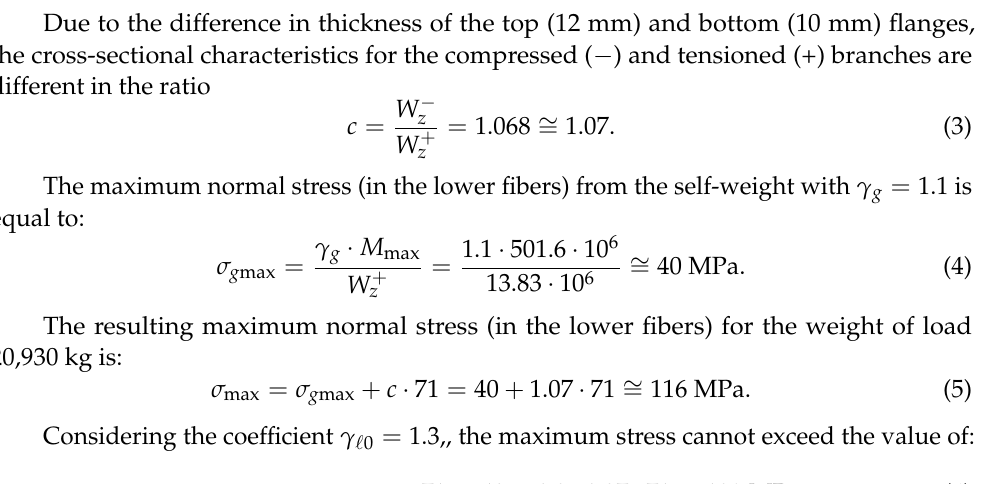
Figure 6. The cross-section of girder: ( a ) at the center of the bridge crane (location of the maximum bending moment), ( b ) at 300 mm distance from the center of the bridge crane.